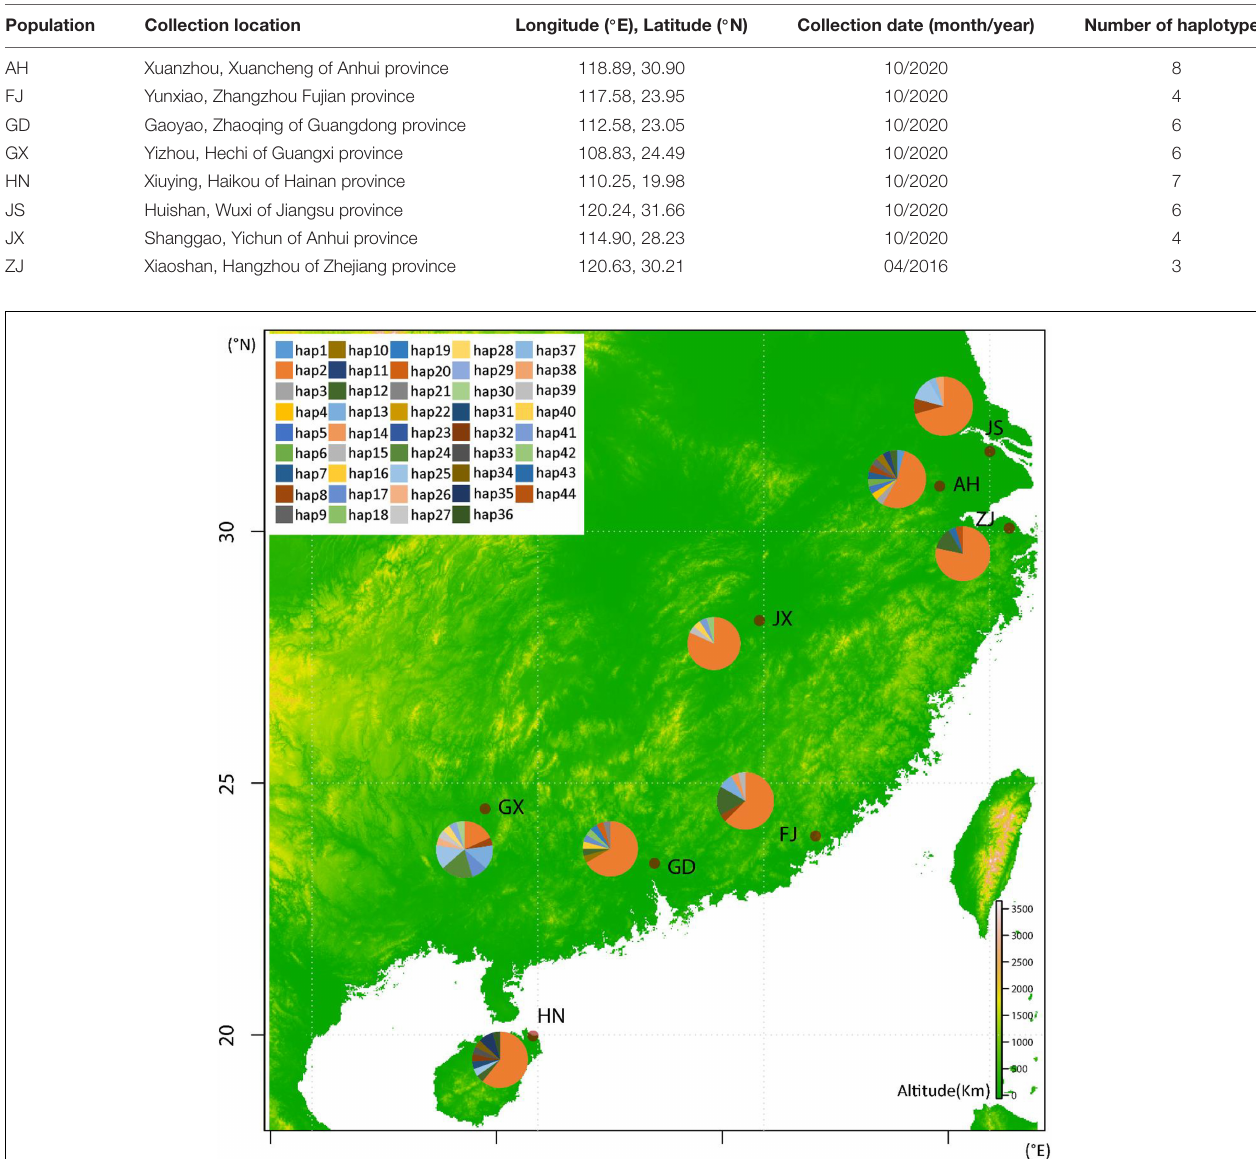
TABLE 1 | Population information of Phyllotreta striolata used in this study.